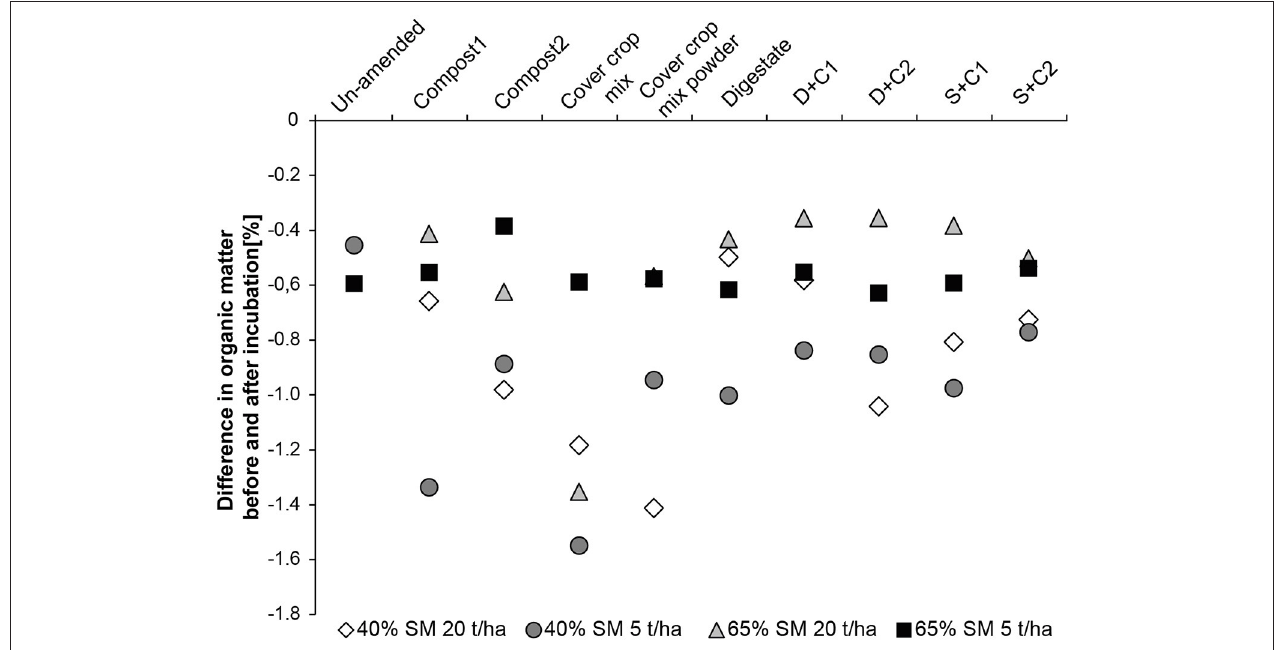
FIGURE 5 | Loss in organic matter content during the incubation period of 28 d in un-amended clay soil and during amendments with compost1, compost2, CC residues mixtures, digestate, digestate + compost1, digestate + compost2, sewage sludge + compost1, and sewage sludge + compost2 (mean ± SD; n = 3) at ( ) high amount (20 t/ha) and high water content (65%), ( (cid:4) ) low amount (5 t/ha) and high water content, ( ♦ ) high amount and low water content (40%), and ( ) low amount and low water